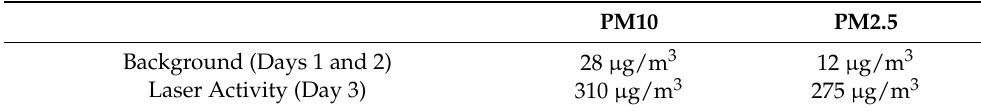
Table 1. Mean Particulate Matter Concentrations during Experiment